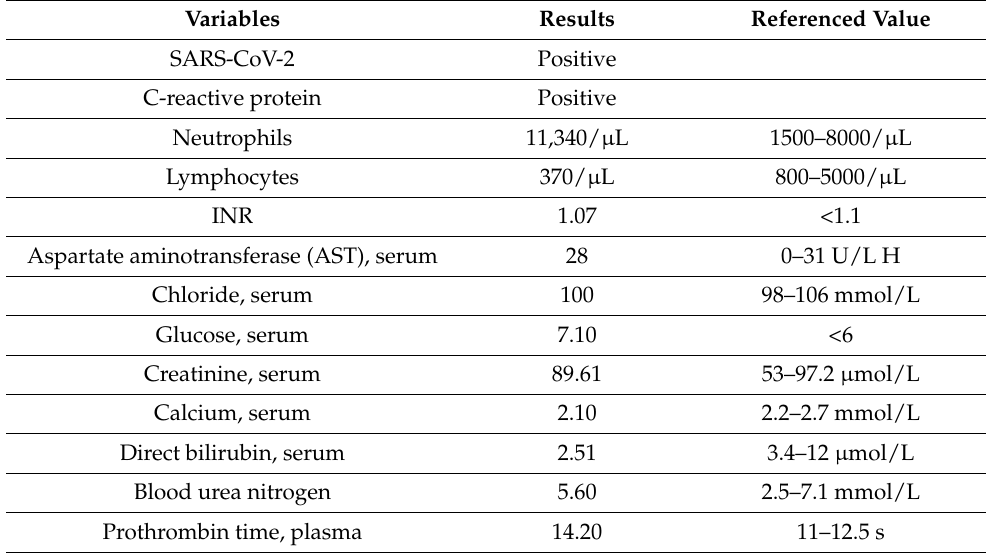
Table 1. Patient’s lab investigations